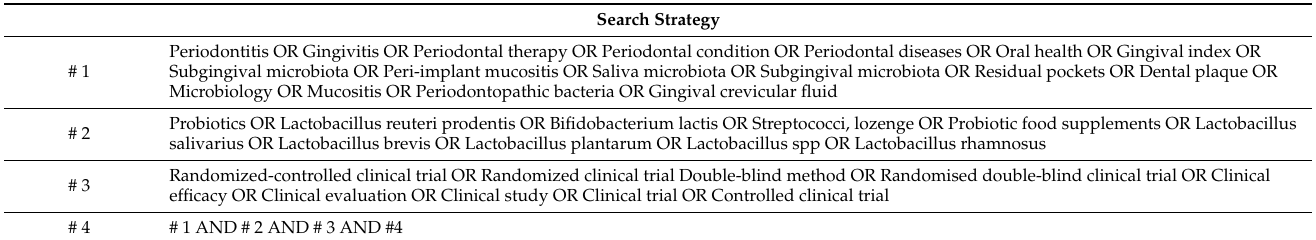
Table 1. Keywords used in search strategy. Search